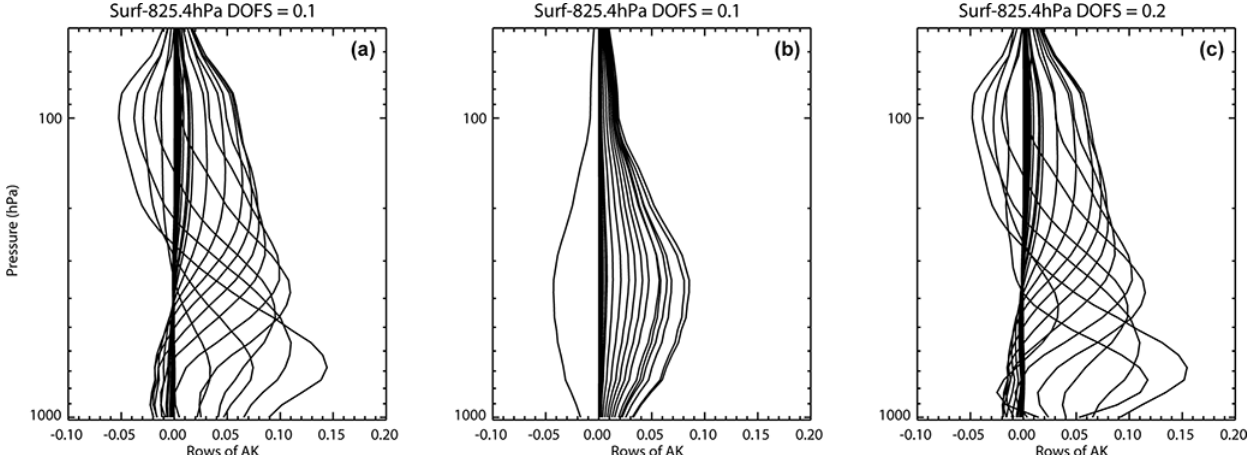
Figure 6. Plots of averaging kernel rows for CO retrievals. The spectral ranges are (from a to c ) MWIR, SWIR, and MWIR + SWIR. These results are for the West Virginia